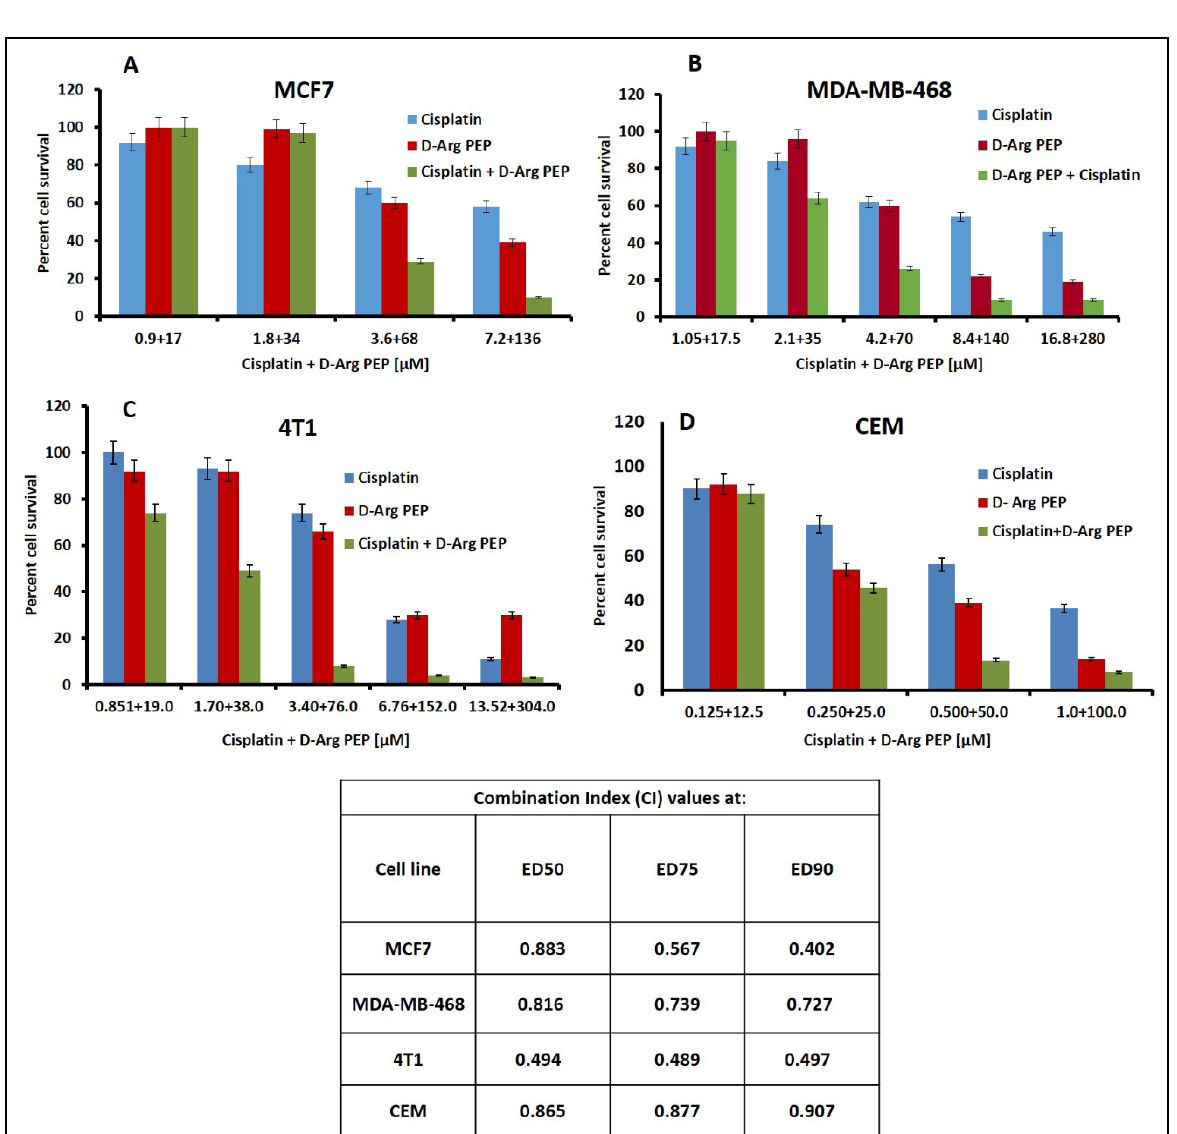
Figure 3. D- Arg PEP shows synergistic cell kill in combination with cisplatin in the breast cancer ( A – C ) and lymphoma ( D ) cell lines. Cisplatin and D-Arg PEP concentration used for combination plates are shown on x axis and the percent cell survival (compared to untreated control) is shown on y axis. These drugs were added in combination at constant ratio as per IC 50 value concentration for individual drugs. The given concentration was also added as a single drug in individual plates. The combination index (CI) values obtained by Chou–Talalay analysis are tabulated below the figure.